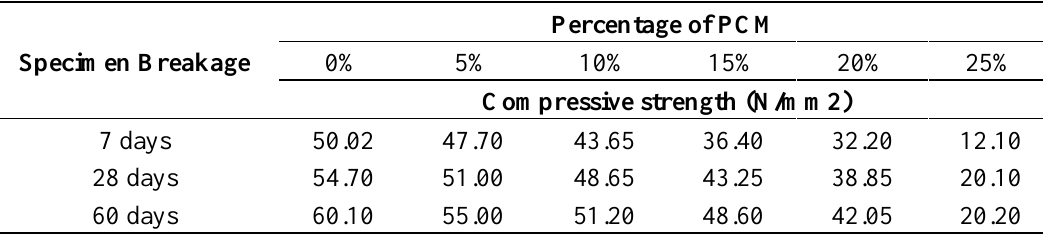
Table 6. Mechanical compressive